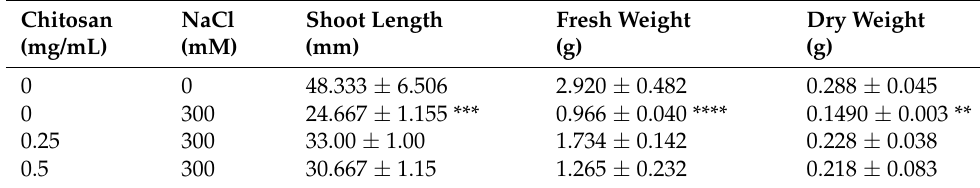
Table 1. Effects of chitosan on growth parameters of salt stressed Sorghum bicolor . Data represented are mean ±